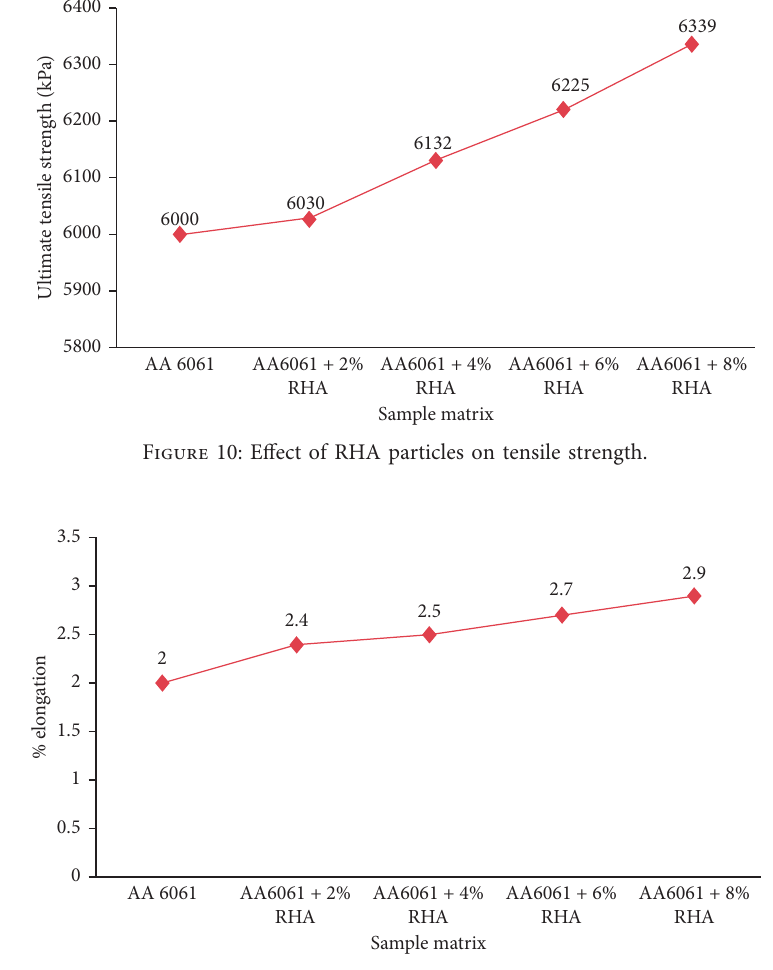
Figure 11: Effect of RHA particles on percentage